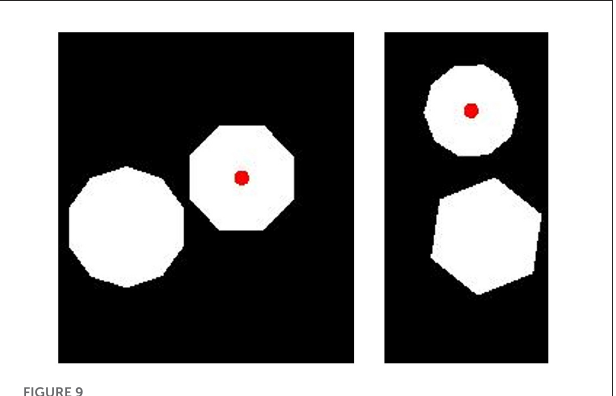
FIGURE9 Sample images for the generalization test in Experiment 3b. (Left) A “Fewer” image. (Right) A “More” image. Category membership was determined by the position of the small, red dot, placed on the polygon with either more or fewer sides.